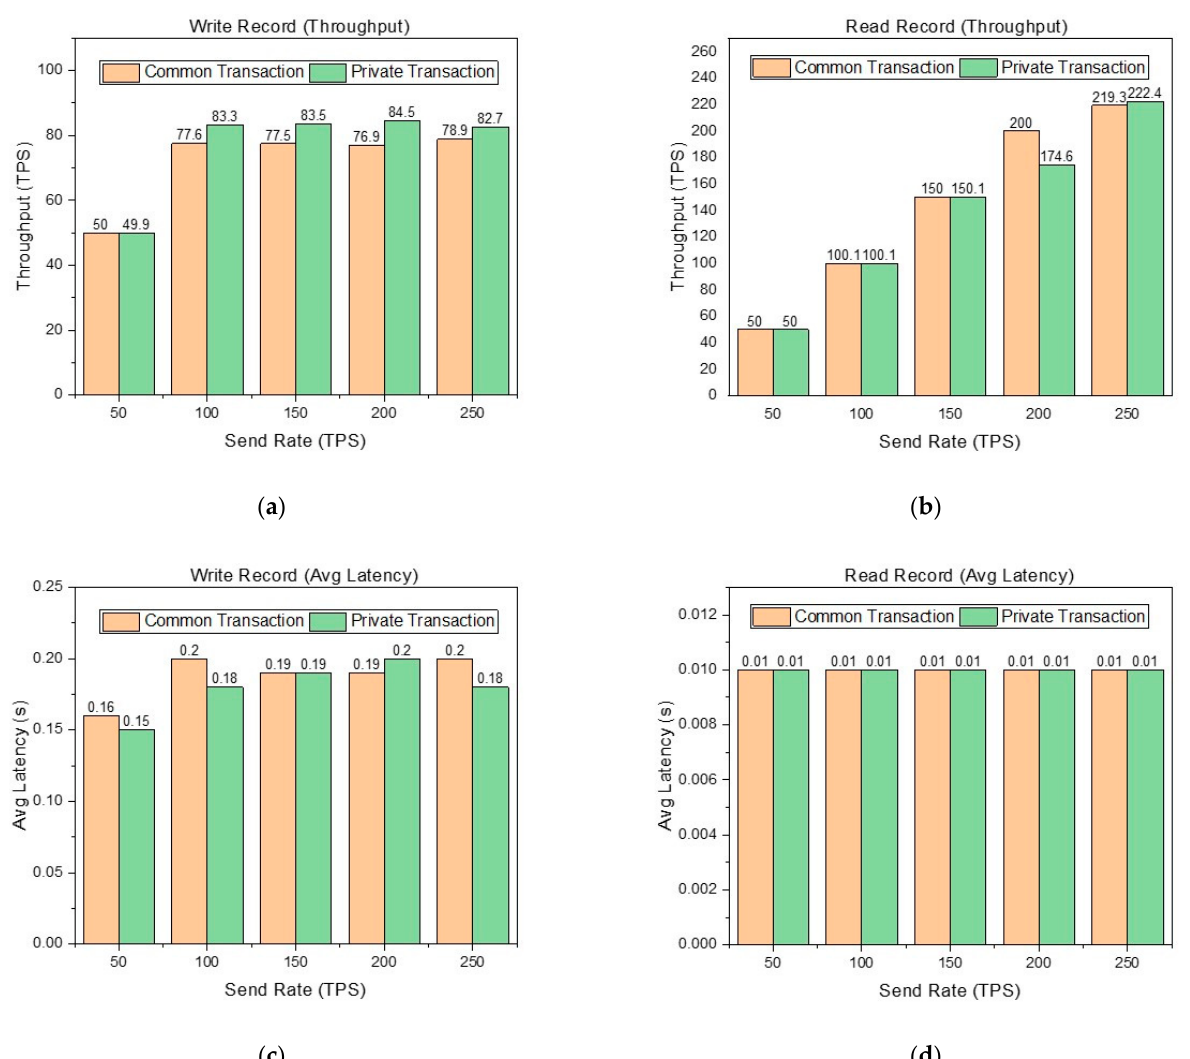
Figure 6. ( a ) Throughput of writing records in the common transaction and private transaction at different sending rates. ( b ) Throughput of reading records in the common transaction and private transaction at different sending rates. ( c ) Average latency of writing records in the common transaction and private transaction at different sending rates. ( d ) Average latency of reading records in the common transaction and private transaction at different sending rates.